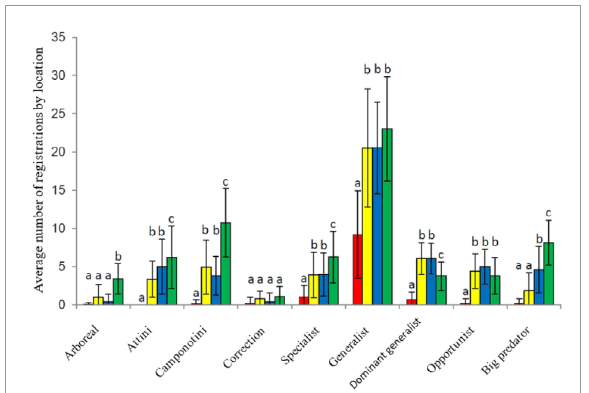
Figure 9: The average number of records per location of ants belonging to different functional groups, collected between June 2019 and August 2020 in the Rashad District using pitfall traps. Error bars indicate standard deviations and different letters indicate significant differences ( p <0.05) between habitats.